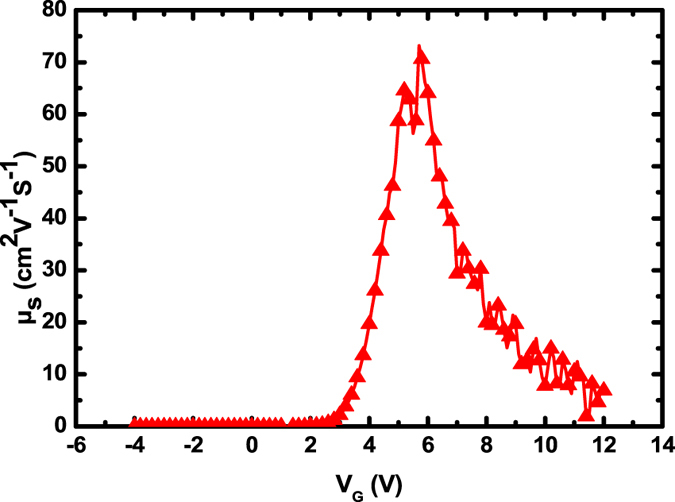
The saturation mobility (μs) versus VG curve of the TZO TFT.